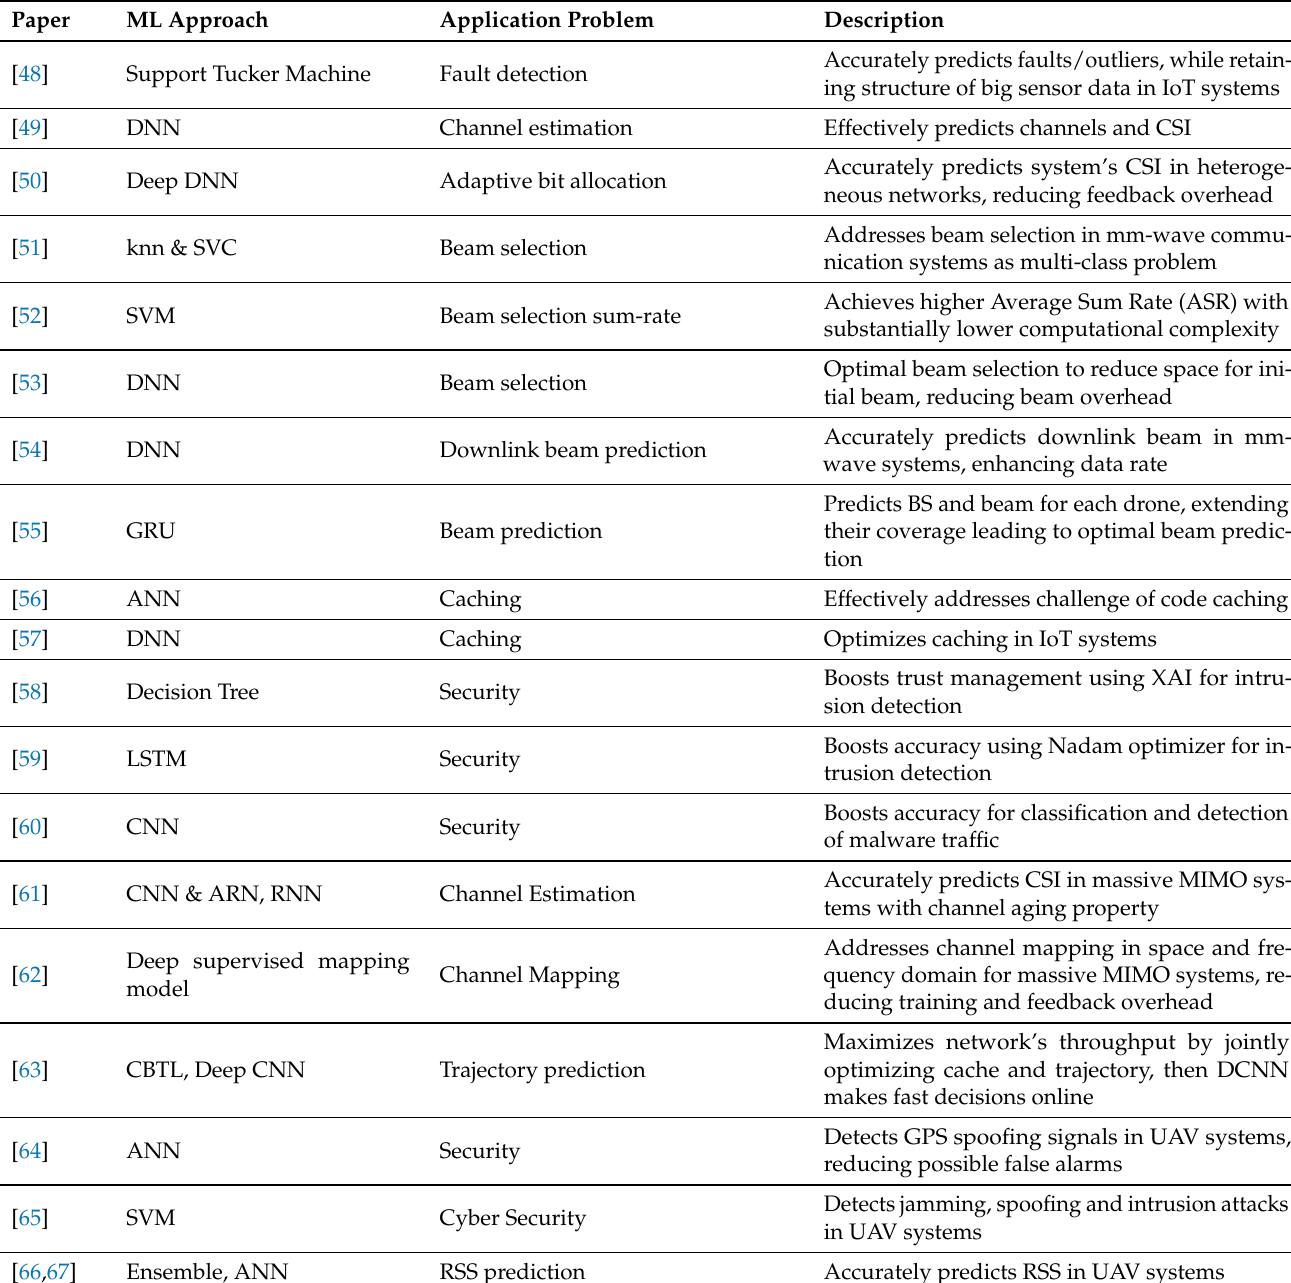
Table 6. Supervised ML models in B5G/6G